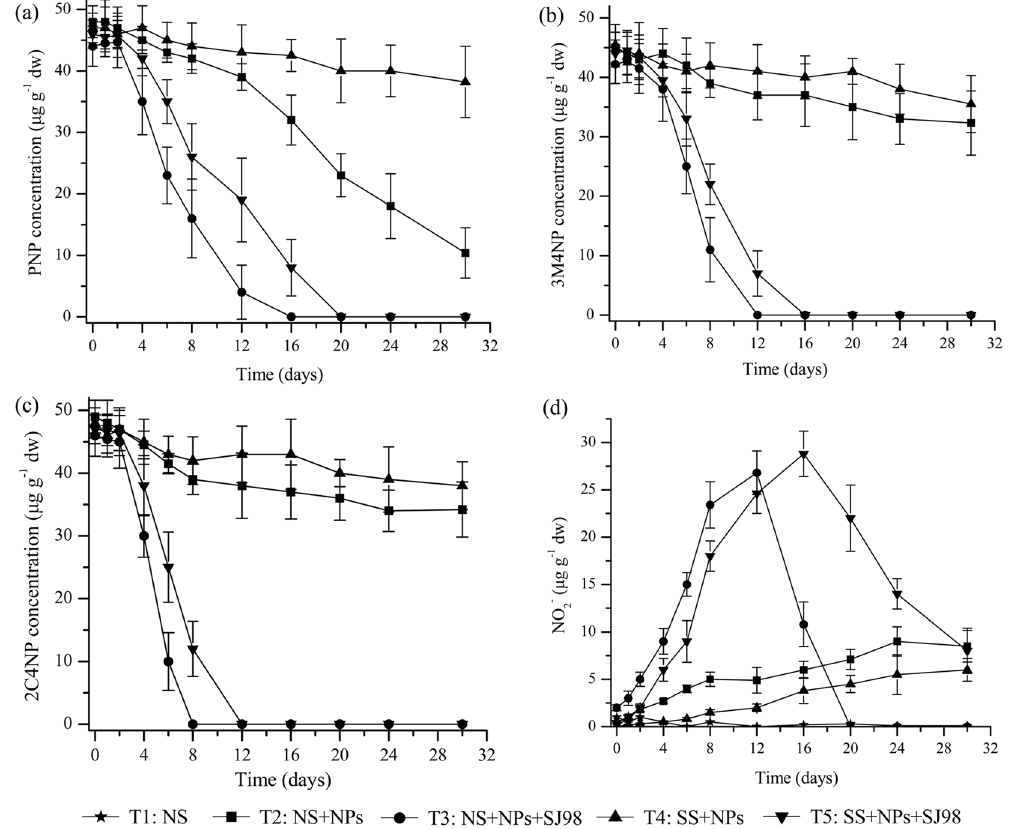
Figure 1. Concentration of nitrophenol pollutants and nitrite in soil microcosms: ( a ) para -nitrophenol (PNP); ( b ) 3-methyl-4-nitrophenol (3M4NP); ( c ) 2-chloro-4-nitrophenol (2C4NP), and ( d ) nitrite (NO 2 − ). Values are means ± standard deviation (n = 3). NS: native soil, SS: sterilized soil, NPs: nitrophenols, and SJ98: Burkholderia sp. strain SJ98.